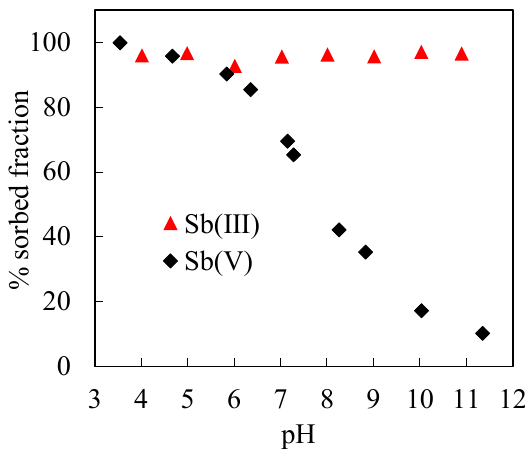
Figure 4. Adsorption of Sb(III/V) onto ferrihydrite as a function of the pH in 0.01 M NaCl solutions. The initial Sb(III/V) concentration were 100 µM for each sample. The concentrations of suspended solids were 0.5 g/L.